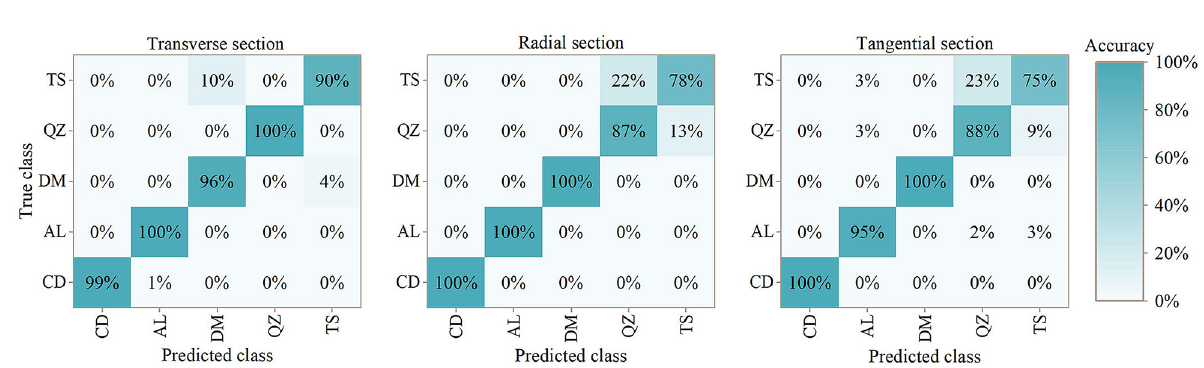
Figure 5. Mixing matrix for results of five Guiboutia species with PLS-DA model. CD = G. conjugate ; AL = G. ehie ; DM = G. demeusei ; QZ = G. coleosperma ; TS = G. tessmannii .